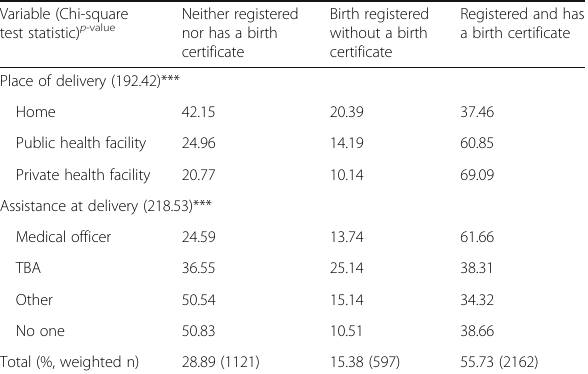
Table 2 Association between child and mothers ’ characteristics, geographic location and delivery characteristics by